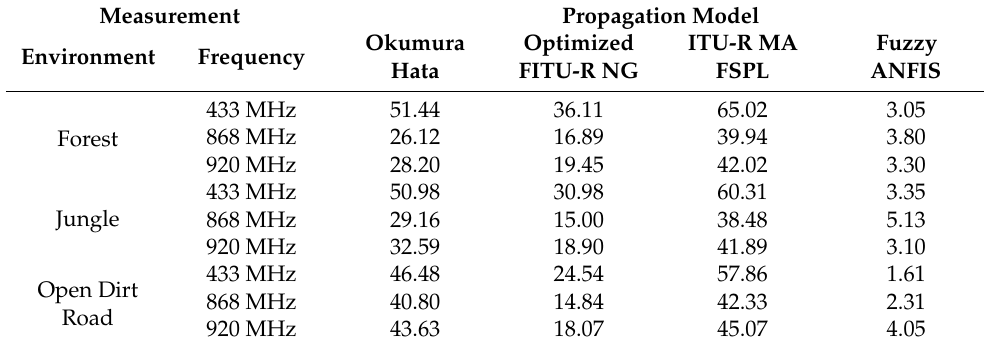
Table 3. Statistical evaluation for each pathloss propagation model using